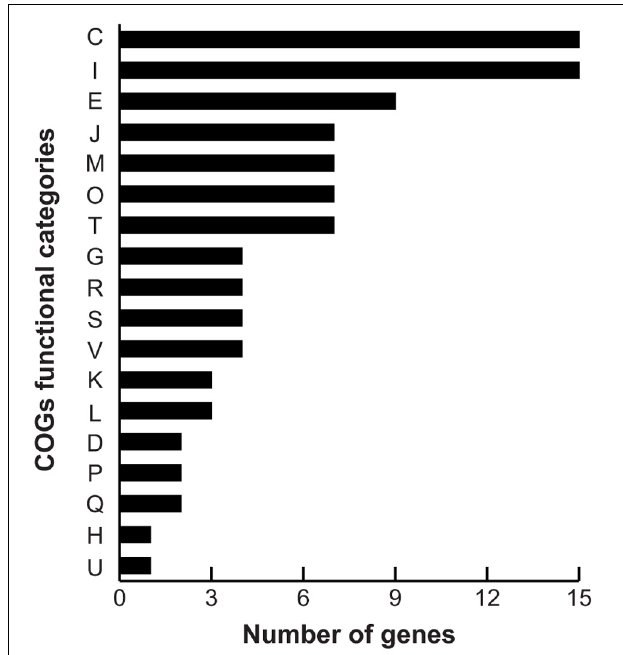
FIGURE 3 | COG summary of differentially expressed genes. COG functional category: C, energy production and conversion; I, lipid transport and metabolism; E, amino acid transport and metabolism; J, translation, ribosomal structure and biogenesis; M, cell wall/membrane/envelope biogenesis; O, post-translational modification, protein turnover, chaperones; T, signal transduction mechanisms; G, carbohydrate transport and metabolism; R, general function prediction only; S, function unknown; V, defense mechanisms; K, transcription; L, replication, recombination and repair; D, cell cycle control, cell division, chromosome partitioning; P, inorganic ion transport and metabolism; Q, secondary metabolites biosynthesis, transport and catabolism; H, coenzyme transport and metabolism; U, intracellular trafficking, secretion, and vesicular